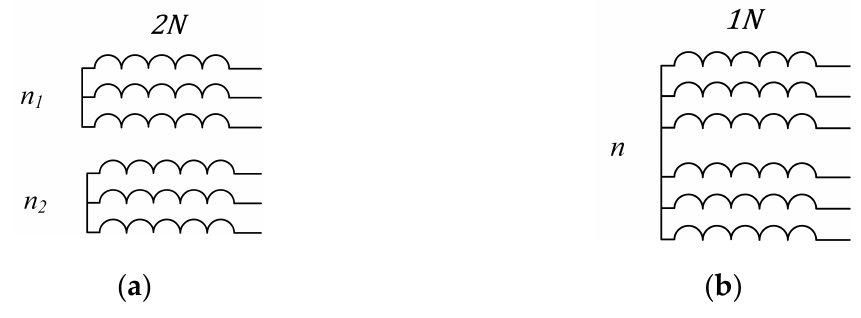
Figure 4. ( a ) Two neutral connections; ( b ) A single neutral connection for six-phase machine winding.